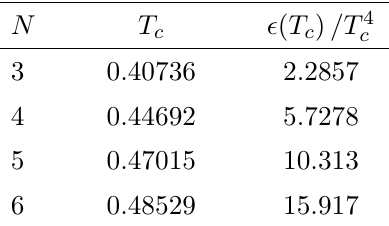
Table 1 . Critical temperature and latent heat in pure gluon case with a = 1 and b N = T 3